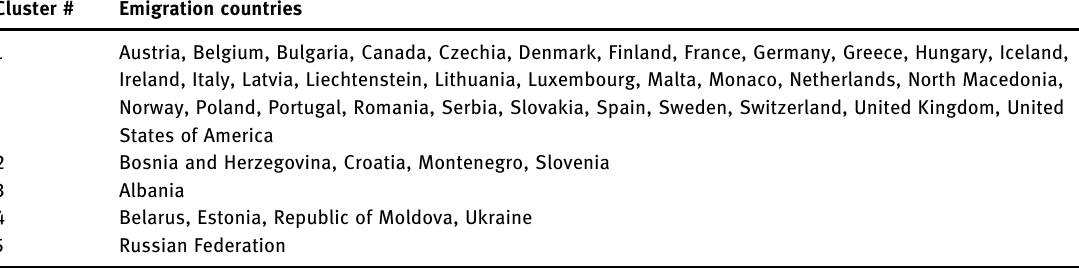
Table 3: Country memberships of emigration trait clusters, 2019 Cluster #